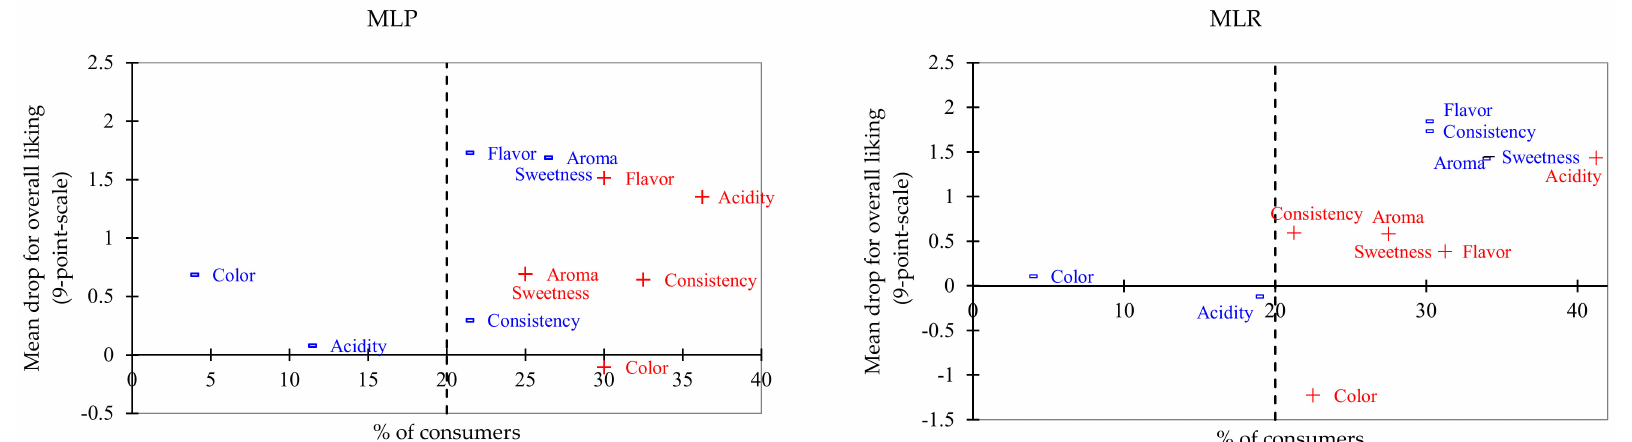
Figure 5. Penalty analysis. A proportion of >20% of consumers (indicated by the — line) who considered an attribute too ‘low’ ( − ) or too ‘high’ (+) and caused a mean drop of >a point was considered significant ( p < 0.05). ( n = 80). Mango juices fermented with MLB— Levilactobacillus brevis ; MLC— Lacticaseibacillus casei ; MLP— Lactiplantibacillus plantarum subsp. plantarum ; MLR— Lacticaseibacillus rhamnosus ; MPP— Pediococcus pentosaceus . Control is mango juice with no lactic acid bacteria under the same conditions of fermentation (24